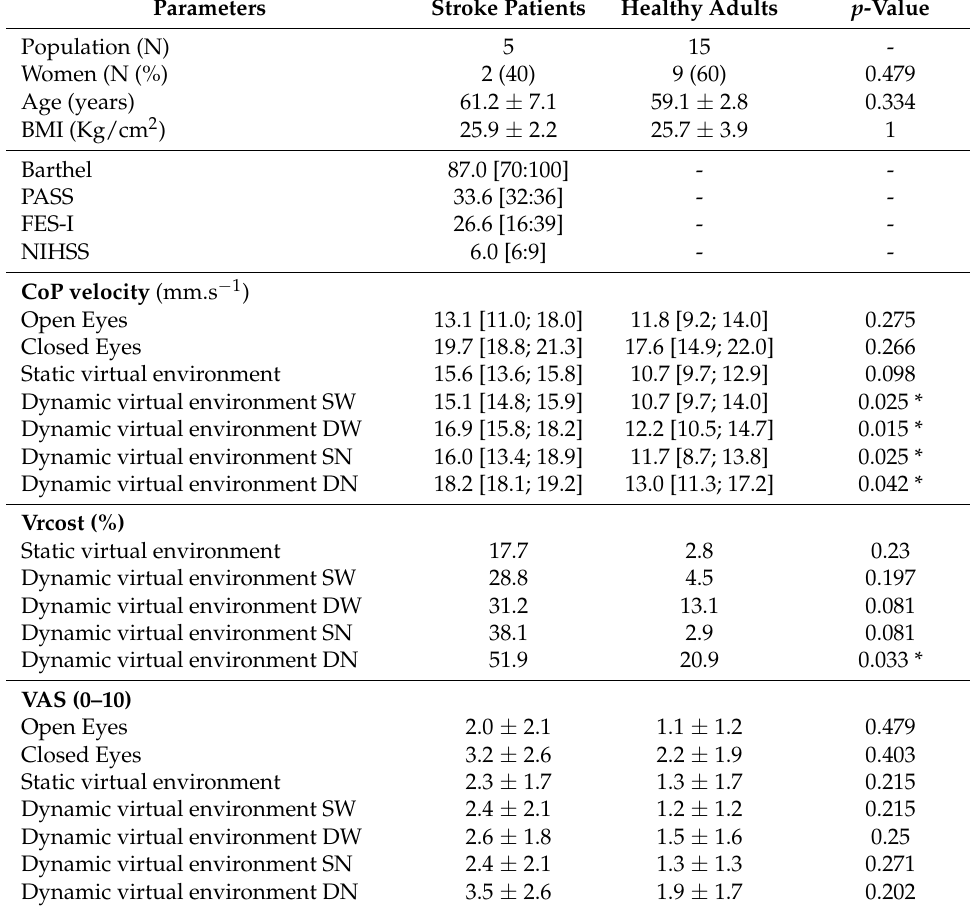
Table 1. Clinical data and postural control